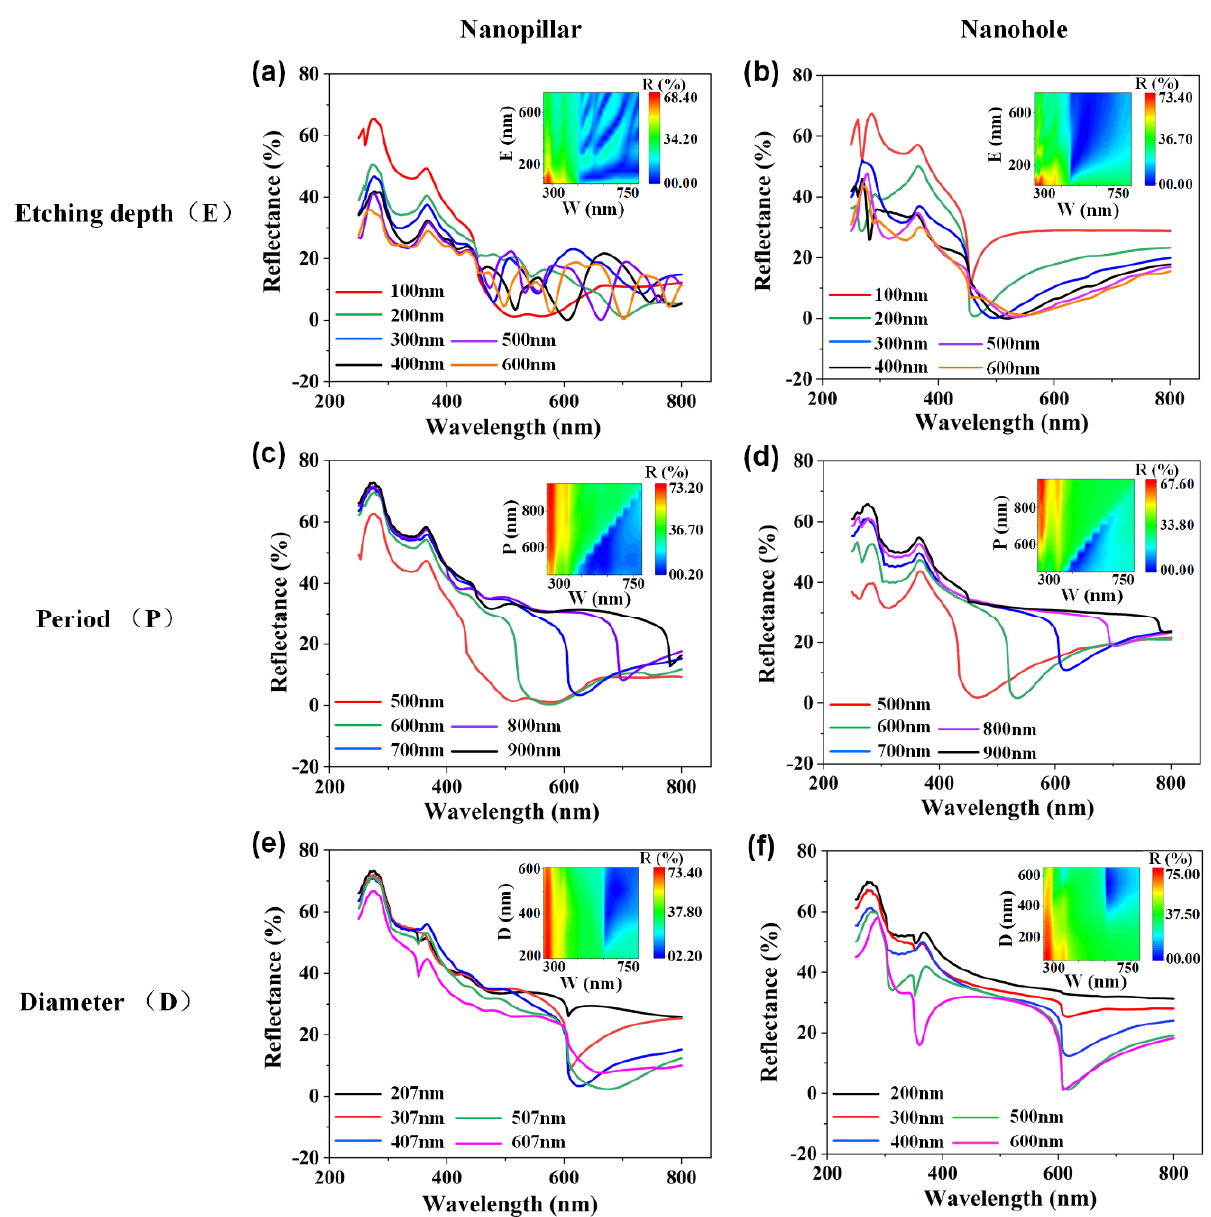
Figure 7. The antireflection properties of the self-assembled nanopillars structures as a function of etching depth ( a ), period ( c ), diameter ( e ). The antireflection properties of the self − assembled nanoholes structures as a function of etching depth ( b ), period ( d ), diameter ( f ). The inset shown the contour plots, which are corresponding to the reflectance curves in the graphs.